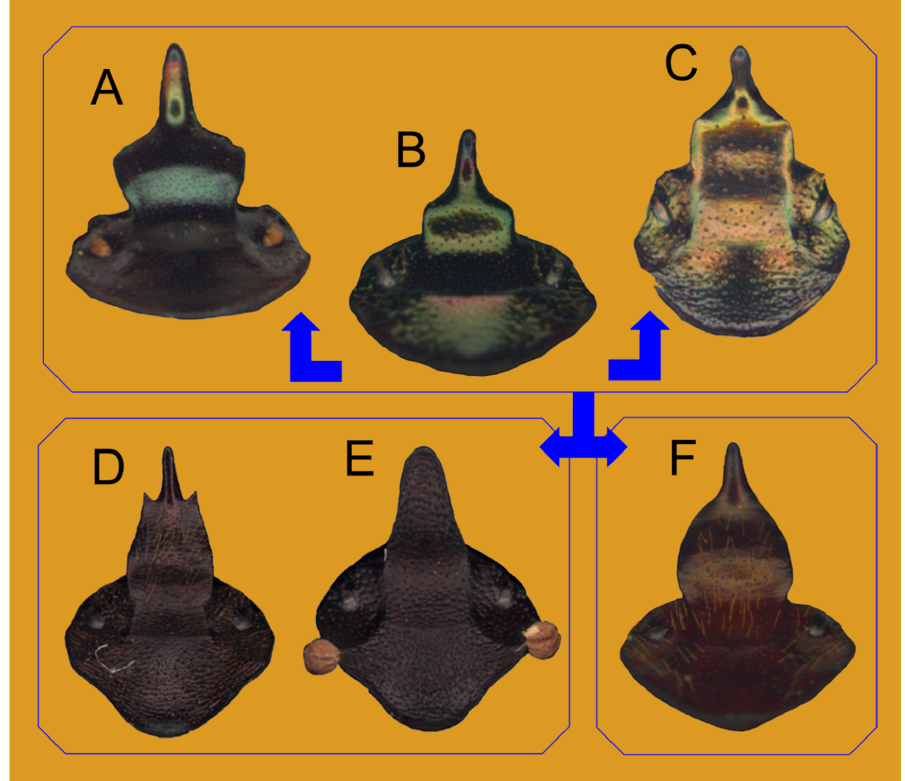
Figure 14. Some examples of the variation pattern of the horn models in Tiaronthophagus major males. (A) : T. rufobasalis . (B) : T. chrysoderus. (C) : T. naevius . (D) : T. jossoi . (E) : T. rufopygus . (F) : T. liberianus — Three major model variation were grouped by boxes, and the arrows suggest potential variation patterns. The B model of lamina is relatively short, and it widens into the A model and then elongates into C model. More obvious changes in shape can be seen in D–E and F